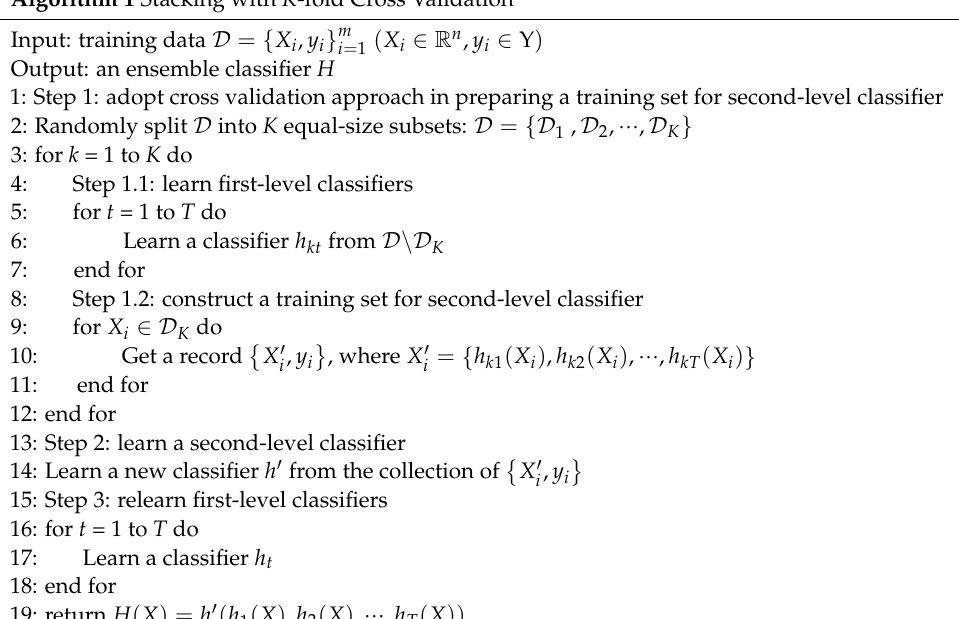
Algorithm 1 Stacking with K -fold Cross